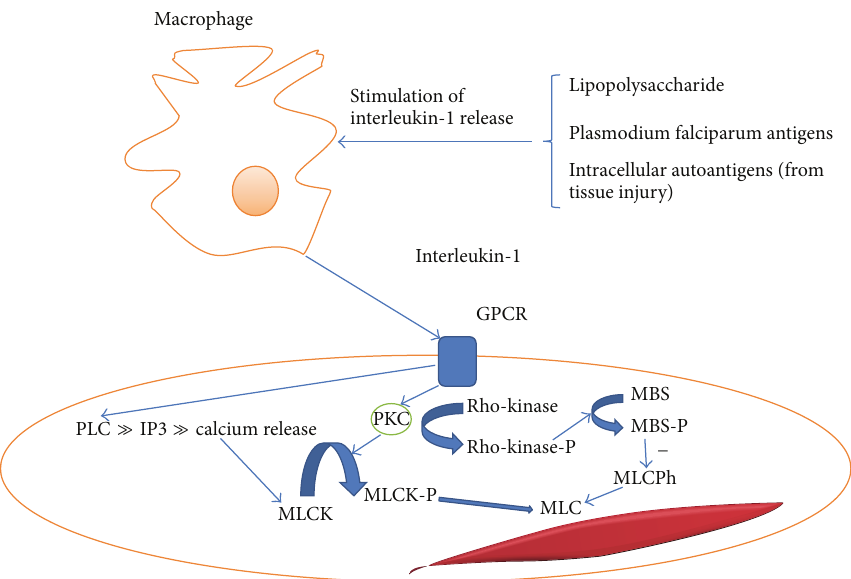
Figure 1: Mechanism for induction of cerebral vasospasm by interleukin-1 (GPCR = G-protein coupled receptor, PKC = protein kinase C, MLCK = myosin light chain kinase, MLC = myosin light chain, MBS = myosin-binding subunit of myosin light chain phosphatase, MLCPh = myosin light chain phosphatase, -P indicates phosphorylated state, PLC = phospholipase C, and IP3 = phosphatidylinositol trisphosphate).